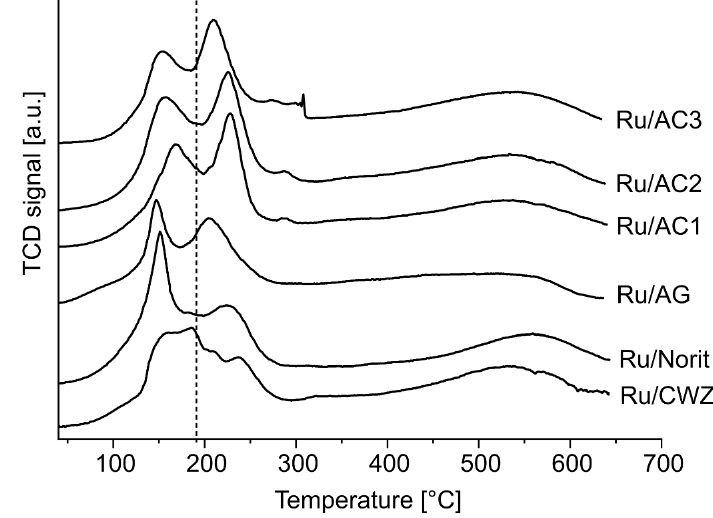
Figure 5. Temperature-programmed reduction (TPR-H 2 ) profiles of ruthenium catalysts.